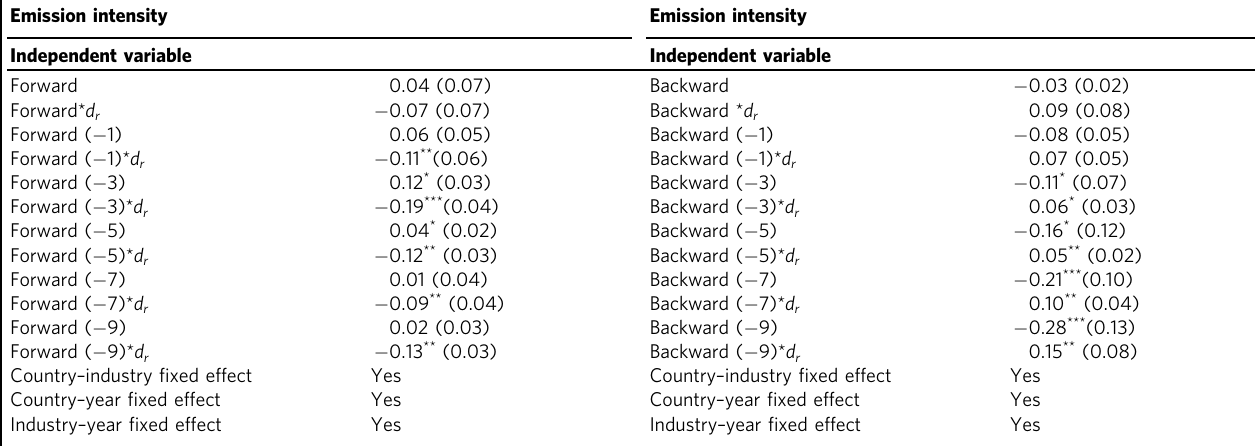
Table 2 GVC participation and emission